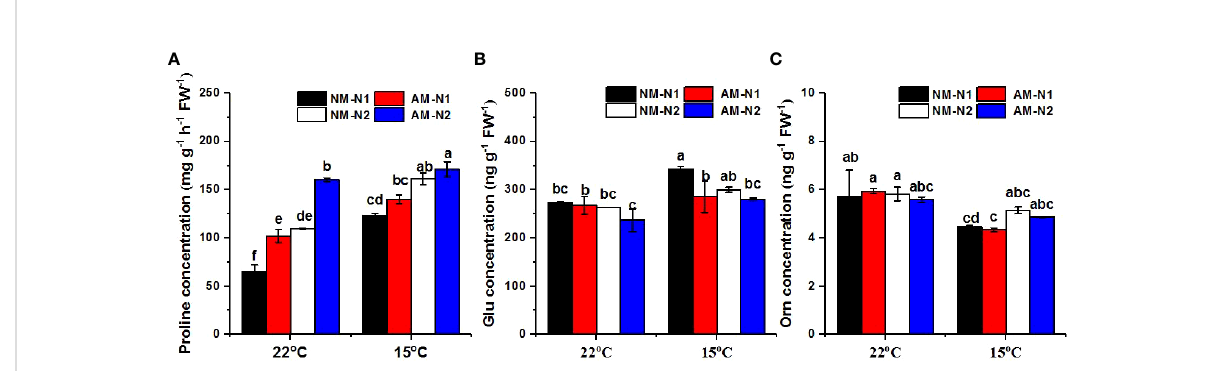
FIGURE 4 Proline (A) , glutamate (Glu) (B) and ornithine (Orn) (C) concentrations of non-mycorrhizal and mycorrhizal rice treated with different temperatures and N levels. Glu, glutamate; Orn, ornithine; AM and NM represent mycorrhizal and non-mycorrhizal rice, respectively, while the